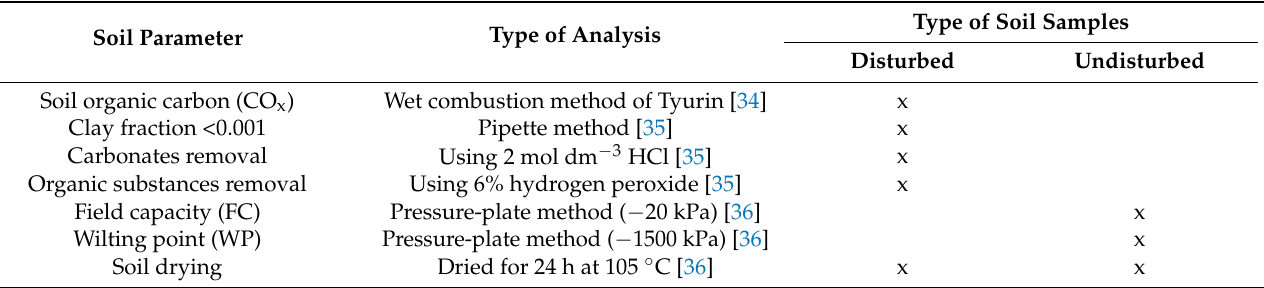
Table 1. Overview of analyses performed for each soil